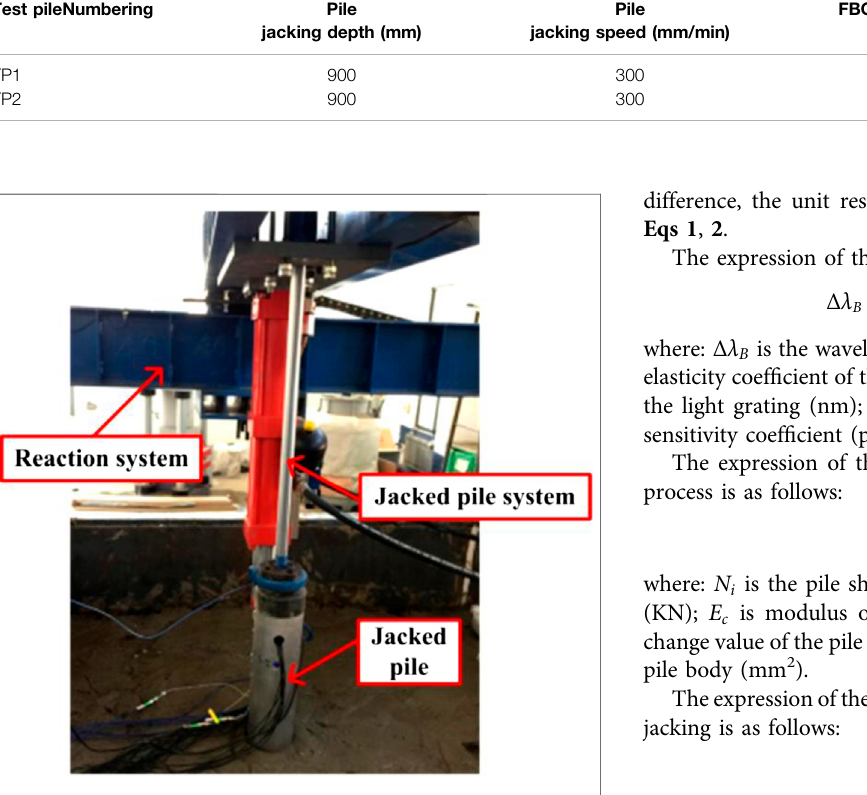
FIGURE 6 | Pile jacking